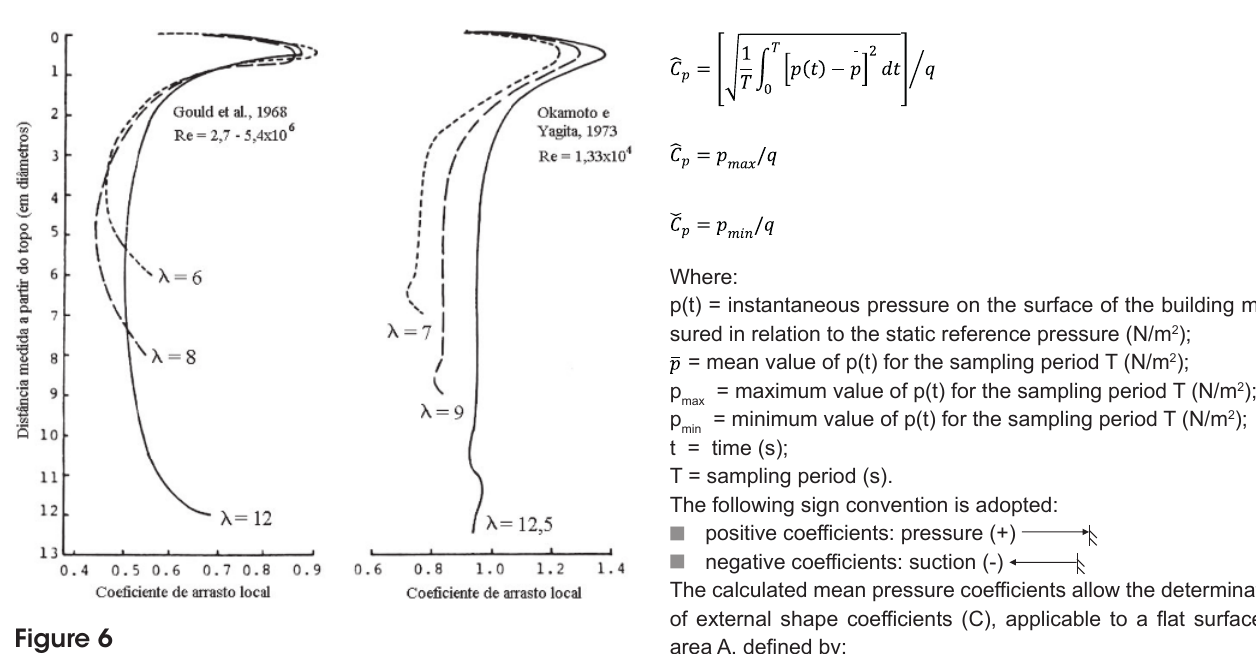
Figure 6 Local drag coeficiente Ca as a function of the distance measured from the top, in diameters, for different slendernesses λ (Cook